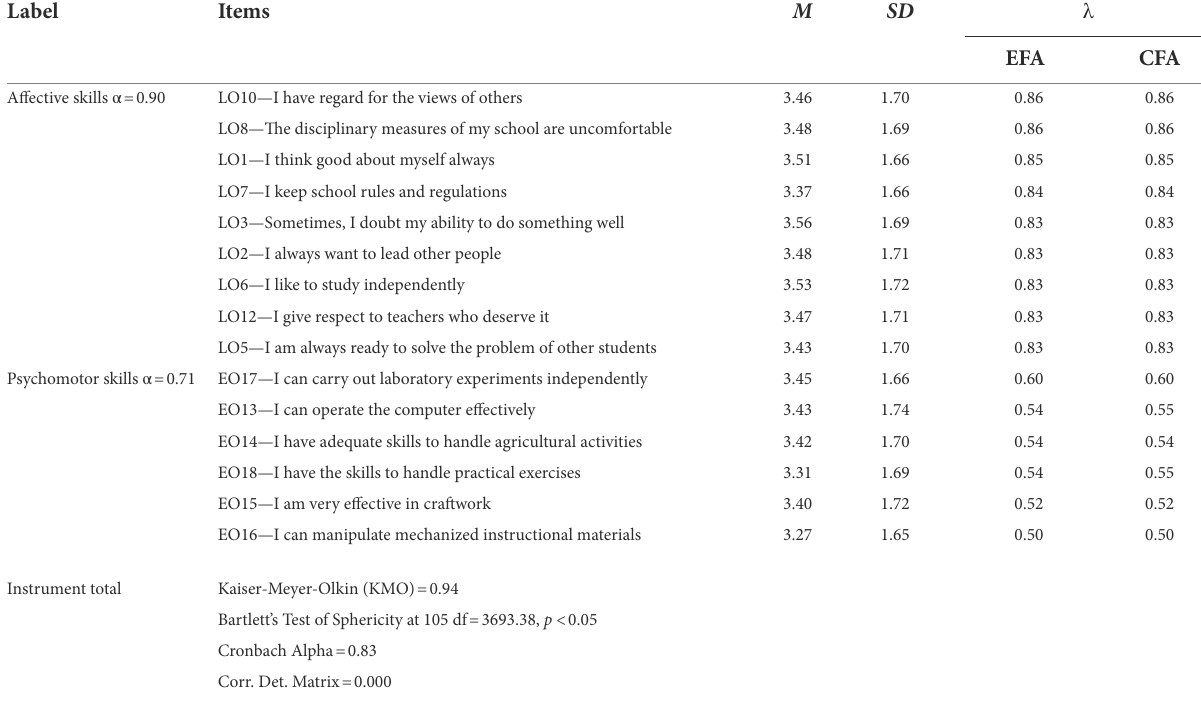
TABLE 2 Exploratory factor analysis of the structure of the